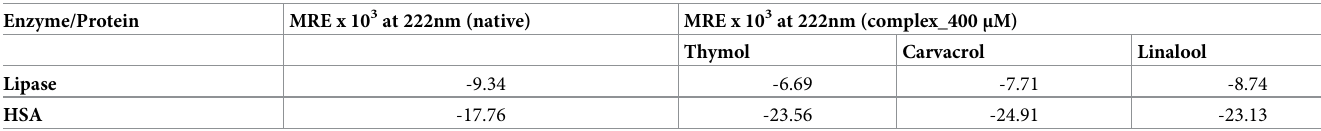
Table 3. Summarises MRE values of free and complexed lipase and HSA.